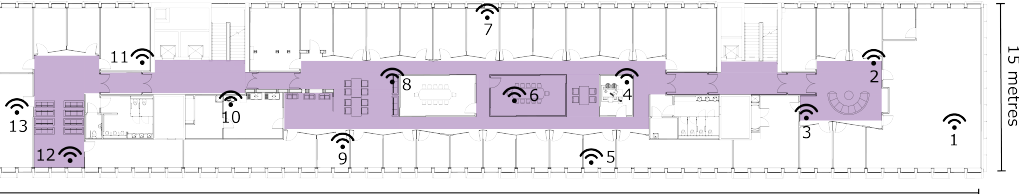
Figure 6. The layout of the building floor. The icons show the locations of the WiFi APs. Mea- surements were taken in the shaded area. The numbers next to the icons indicate the IDs of the Access